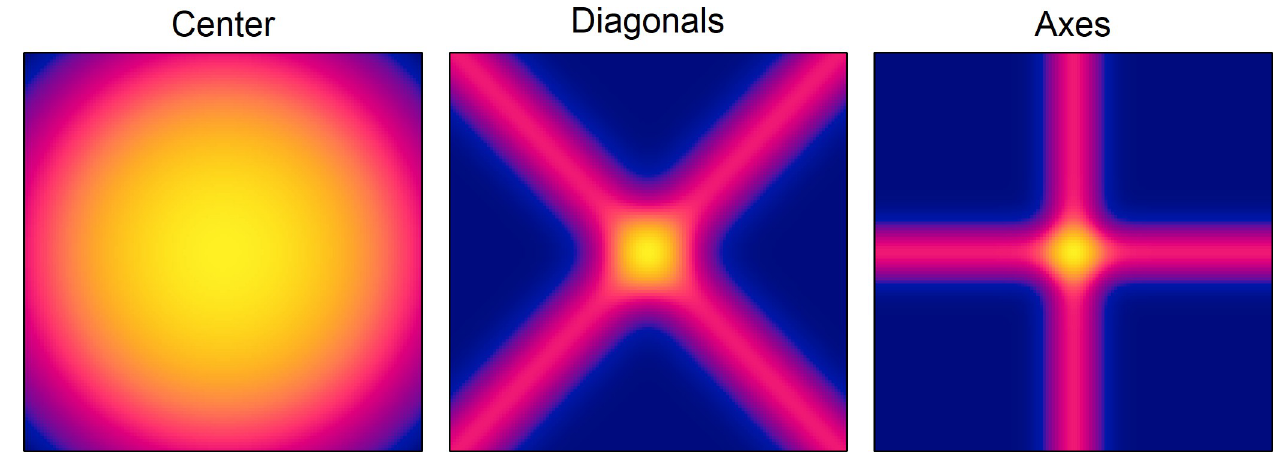
Fig 2. Estimated maps of attraction for the three regional components (center, diagonals, and axes) for condition 10S in Experiment 1. The range of values in the three maps are 6.0849x10 -5 to 6.1131x10 -5 , 2.3756x10 -10 to 2.7611x10 -4 , and 2.0420x10 -25 to 4.8591x10 -04 , respectively.